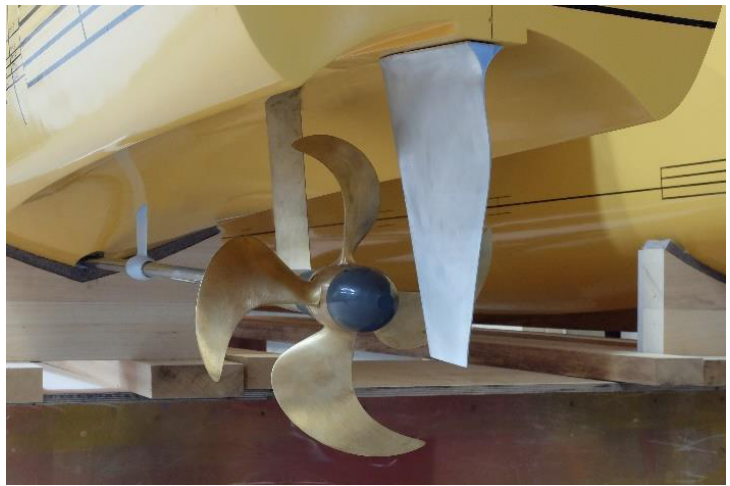
Figure 15. Close-up of the stern area of the tested Stavanger model, with fitted propellers, shafts, brackets and rudders.